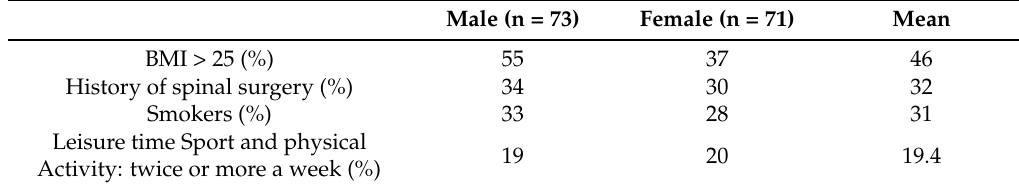
Table 2. Male and female percentages of clinical characteristics before rehabilitation.